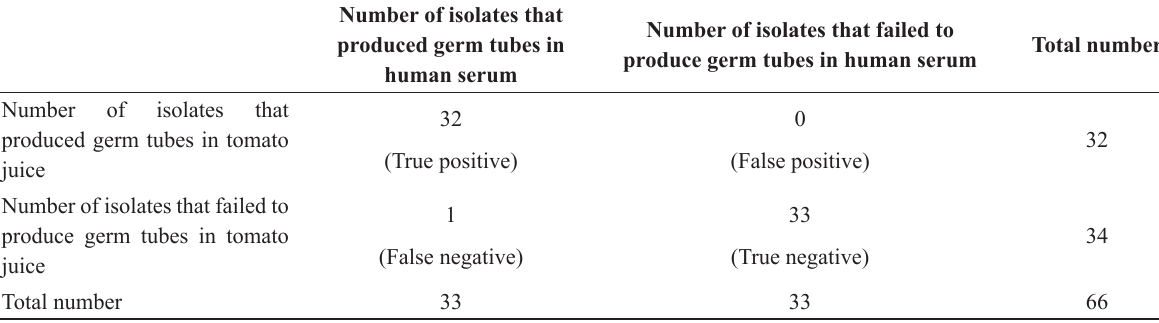
Table 1: Germ tube test result for clinical and standard Candida isolates in human serum and tomato juice.